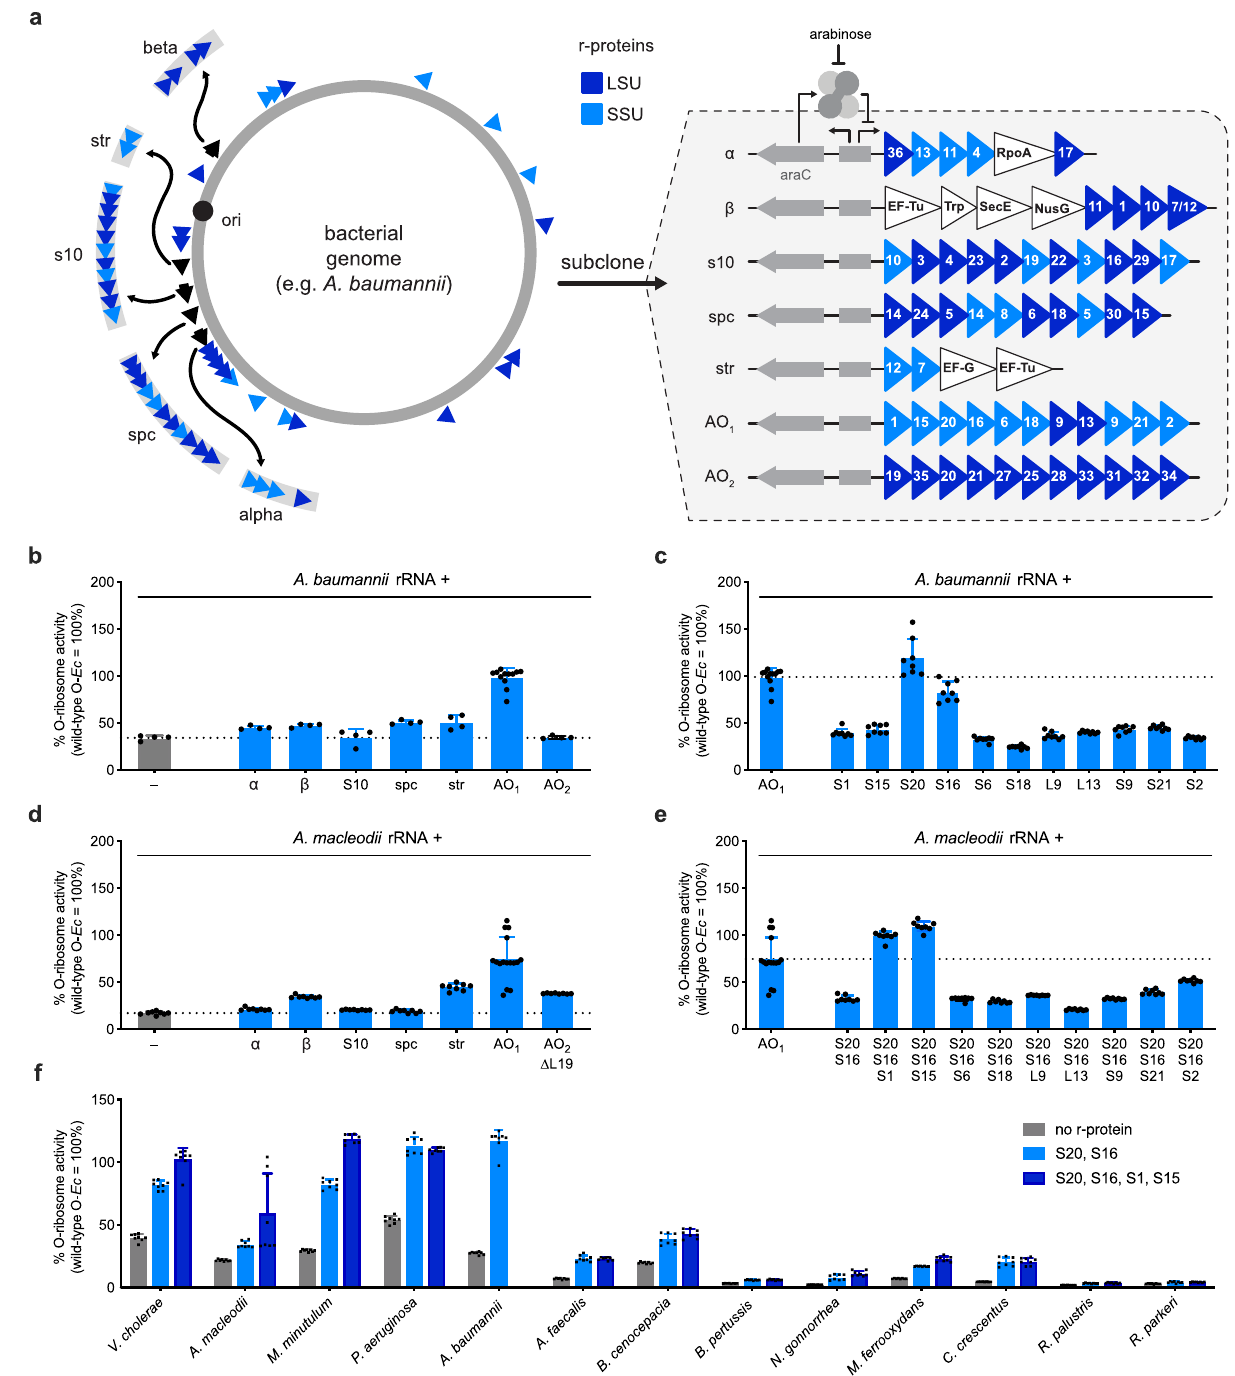
Fig. 4 Cognate r-proteins complementation improves heterologous O-rRNA activity. a Schematic representation of natural ribosomal protein (r-protein) genomic organization for a given microbial genome and corresponding plasmid architecture for heterologous orthogonal ribosomal RNA (O-rRNA) complementation. b A. baumannii AO 1 enhances cognate heterologous rRNA activity ( n = 8 for AO 1 ; otherwise n = 4). c A. baumannii S20 and S16 enhance A. baumannii O-ribosome activity to levels comparable to E. coli O-ribosomes ( n = 8 for AO 1 ; otherwise n = 4). d A. macleodii AO 1 similarly improves cognate heterologous rRNA activity ( n = 16 for AO 1 ; otherwise n = 8). AO 2 is expressed with L19 deleted due to observed toxicity (Supplementary Figs. 6a, b). e Cognate S1 or S15, alongside S20 and S16, maximize A. macleodii O-ribosome activity ( n = 16 for AO 1 ; otherwise n = 8). f Cognate S20, S16, S1, and S15 supplementation alongside cognate heterologous O-rRNAs. Toxicity is observed when expressing the four proteins together in A. macleodii and A. baumannii (Supplementary Fig. 7a; n = 8). Data re fl ect the mean and standard deviation of 4 – 16 biological replicates. Comprehensive O-translation data reported in Supplementary Table 1. Wild-type O- Ec wild-type orthogonal E. coli rRNA, SSU small subunit, LSU large subunit. Source data are available in the Source Data